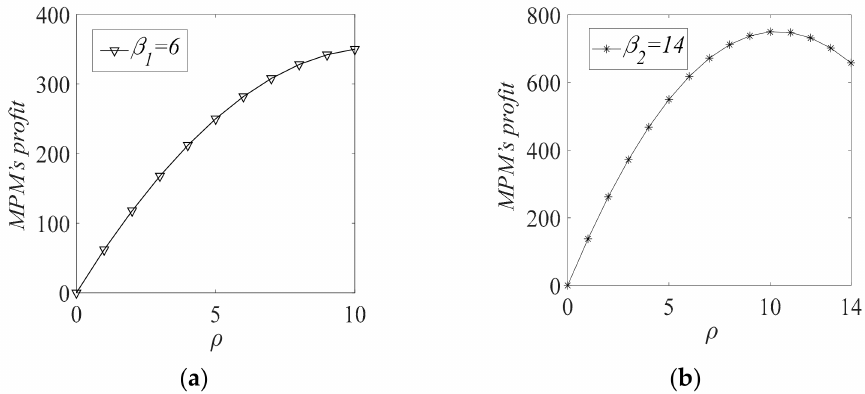
Figure 3. Impact of the recycling commission on the ORP’s profit under different customers’ prefer- ence of the recycling price.: ( a ) When β is weak ( β 1 = 6); ( b ) When β is strong ( β 2 =